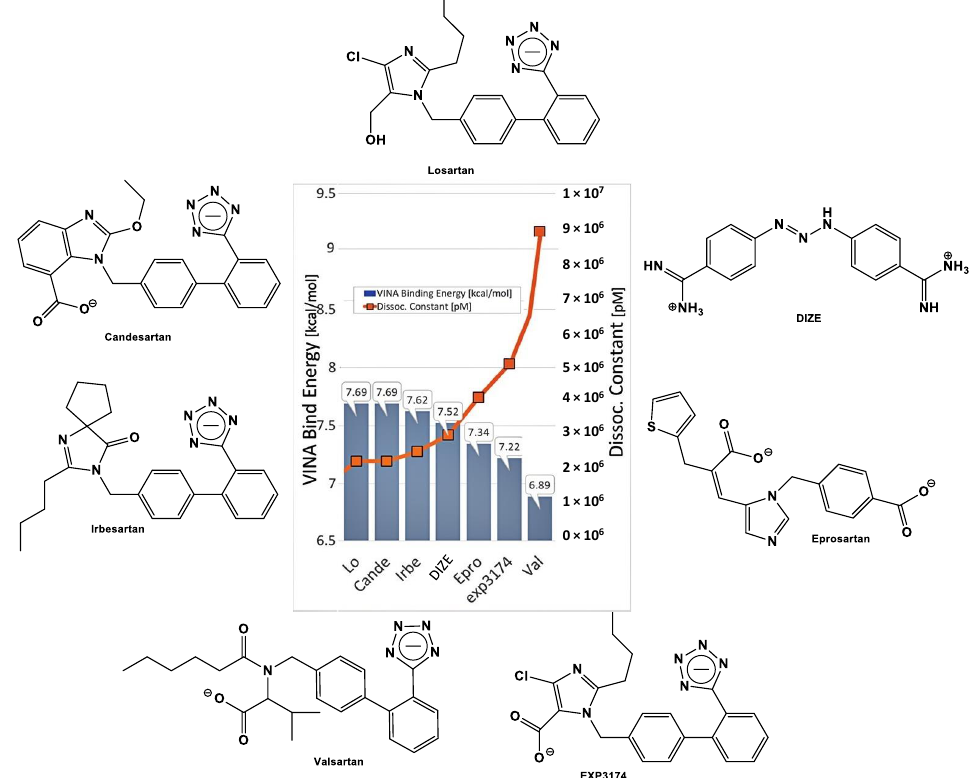
Figure 10. Docking of DIZE and ARBs (Lo, Cande, Irbe, epro, Exp3174 and Val) to the zinc pocket of the SARS-CoV-2 RBD/ACE2 complex. AutoDock VINA-binding energies are illustrated in the central plot with columns. Dissociation constants are represented by the orange line with square markers. Based on the VINA docking metric, the order of binding was: losartan > candesartan > irbesaratan > DIZE > Epro > Exp3174 > valsartan. Abbreviations: Lo, losartan; Cande, candesartan; Irbe, irbesartan and Val,